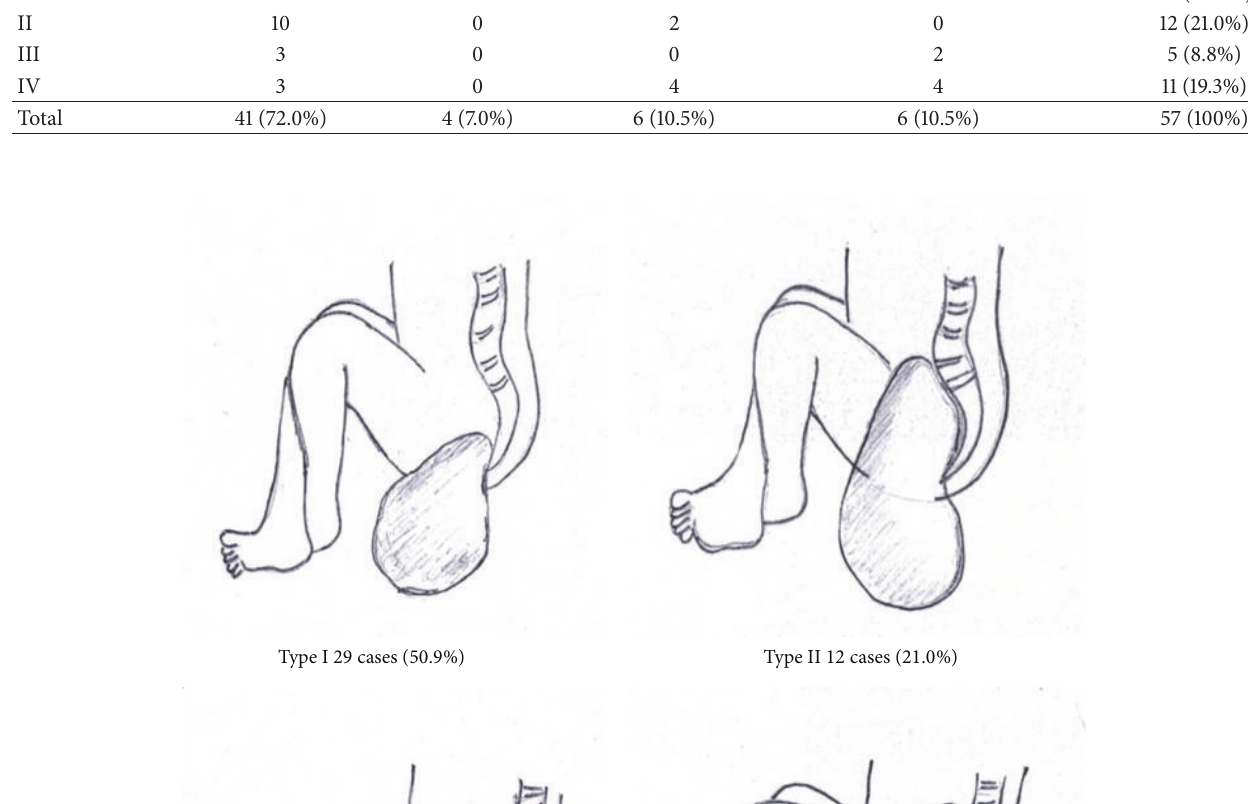
excision in the other 2. The total 57 cases of SC-GCT